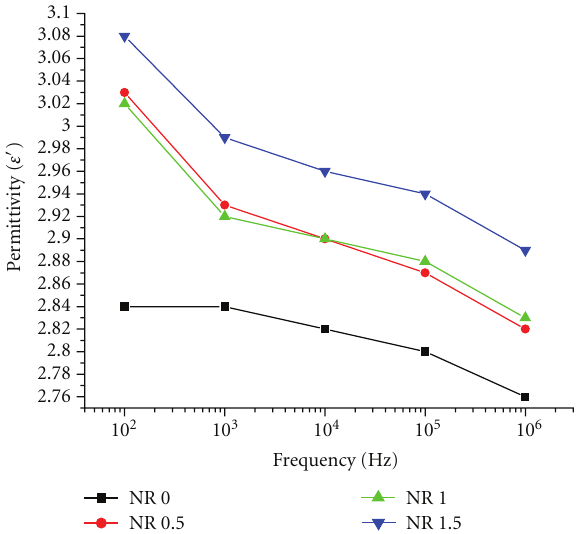
Figure 7: Frequency dependence of dielectric permittivity at a di ff erent degree of fullerene filling at 90 ◦